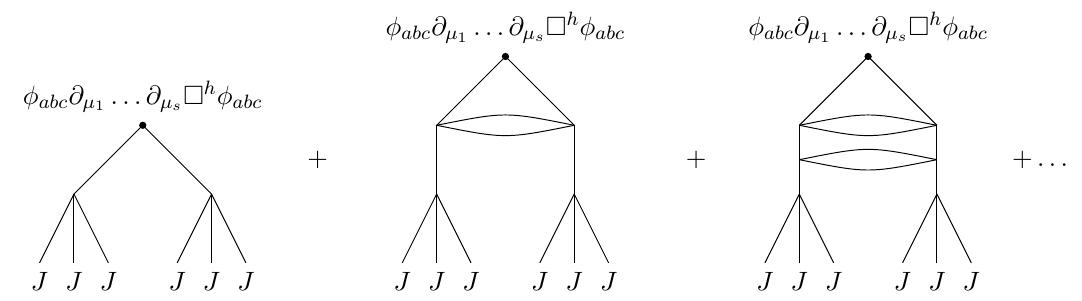
Figure 10 . The diagrams that contribute to the non-vanishing vacuum expectation value of the (cid:3) h φ bilinear operator φ abc ∂ µ . . . ∂ µ abc . In comparison to the operator φ 111 , here we need to include 1 s the ladder